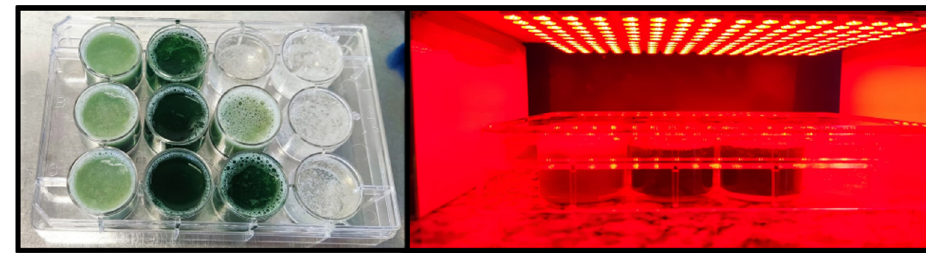
Figure 2. Illumination of Phy-Chl and Phy-CO-Chl